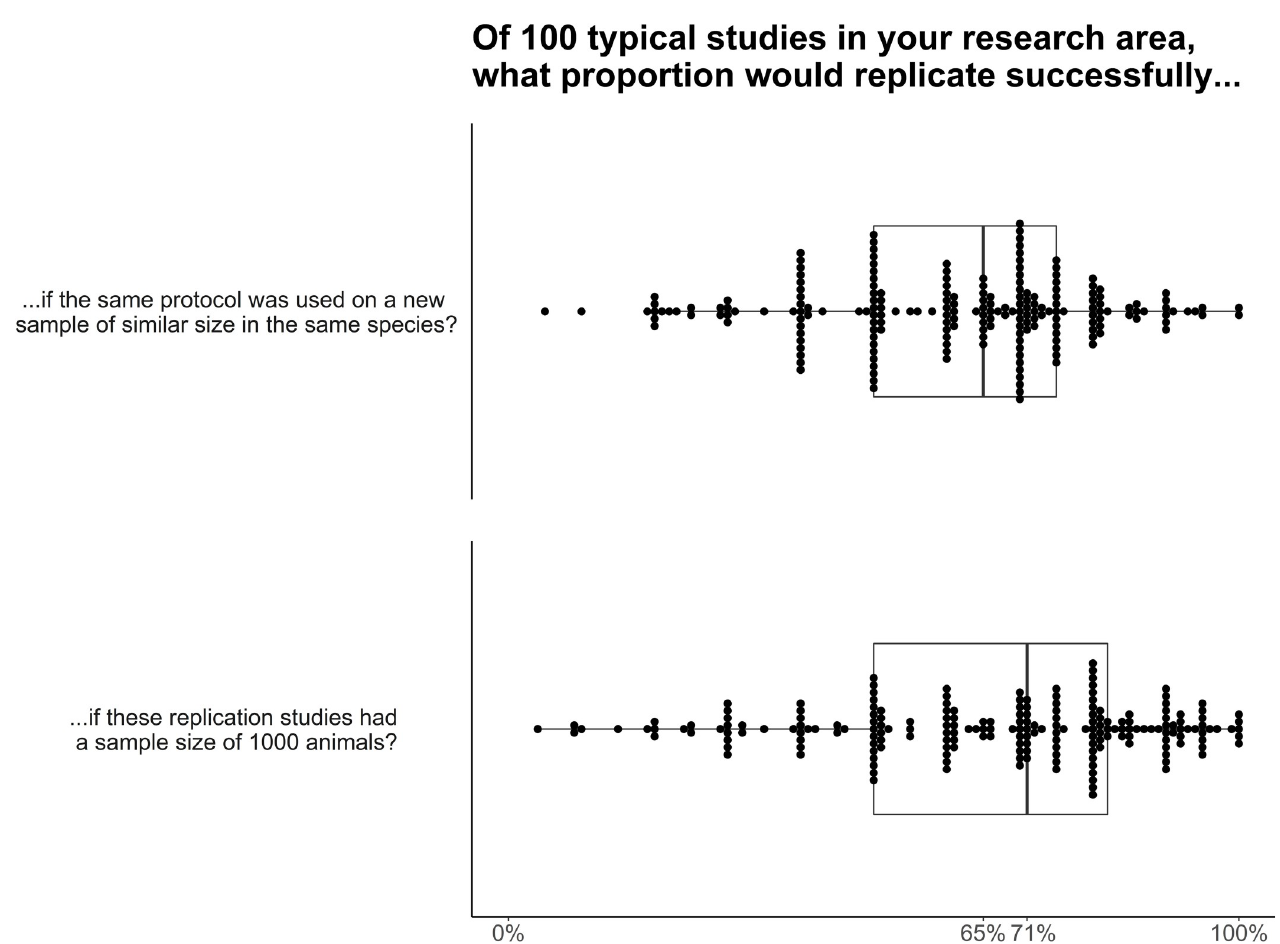
Fig 13. Animal cognition researchers’ predictions of replication success in their field, N same sample size = 207, N large sample = 205. Each dot represents one researcher’s estimate of what proportion of studies in their research area would successfully replicate if these studies were replicated with a similar sample size (top panel) or a sample size of 1000 animals (bottom panel), with boxplots showing the median and inter-quartile ranges laid underneath.